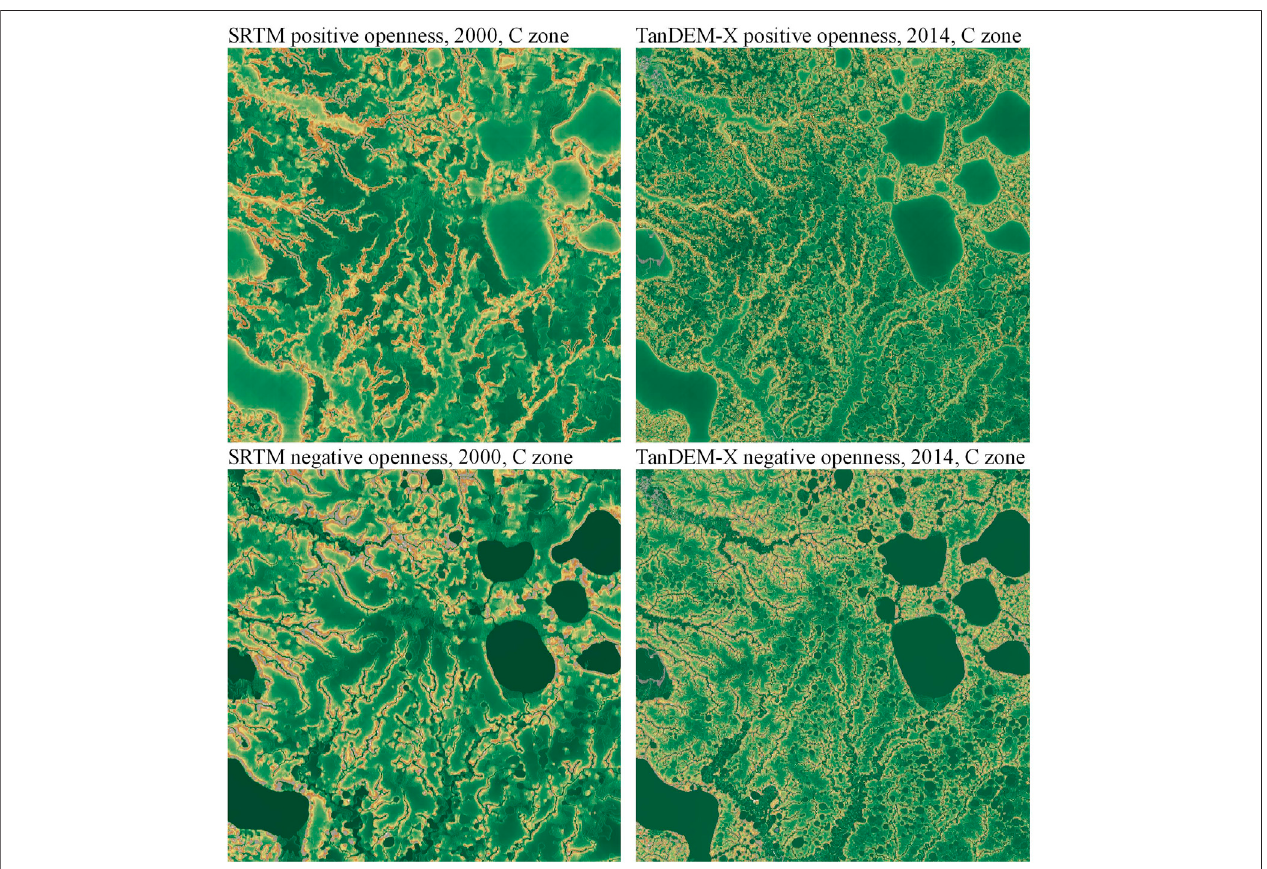
FIGURE 10 | SRTM and TanDEM-X DEMs openness metric showing surface relief changes over 14 years for C zone. Positive openness highlights the drainage network changes. Negative openness highlights the shape of lakes and formation of new lakes.